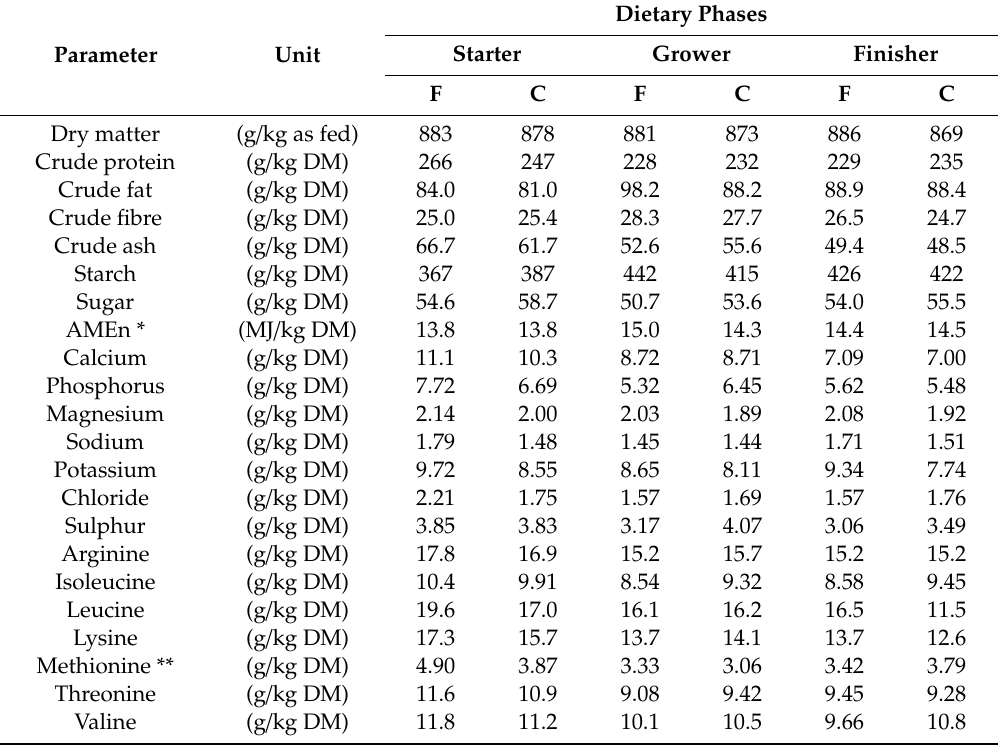
Table 3. Chemical analyses of the experimental diets during the di ff erent fattening phases.